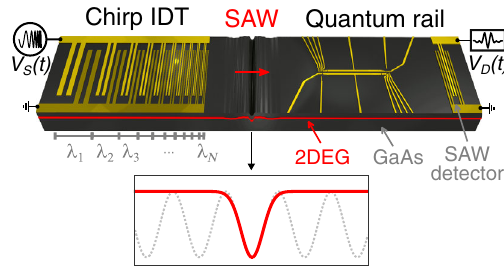
FIG. 1. Experimental setup. Schematic of chirp IDT launching a compressed SAW towards a quantum rail and a subsequent broadband SAW detector. We show a perspective view on the sample that is realized via metallic surface gates in a GaAs = AlGaAs heterostructure. Inset: comparison between the periodic SAW modulation from regular transduction (dotted gray line) with the ideal SAW profile for electron transport consisting of a single propagating minimum (red